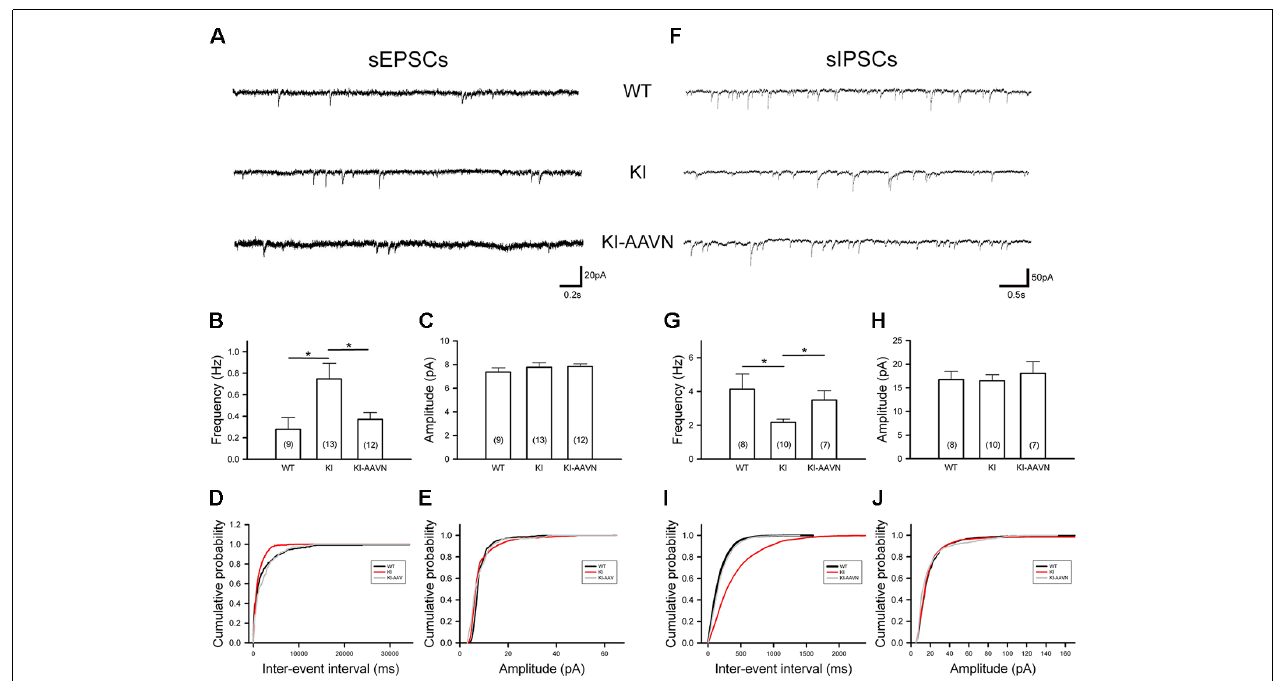
FIGURE 5 | Spontaneous excitatory postsynaptic currents (sEPSCs) and spontaneous inhibitory PSCs (sIPSCs) recorded from SNc DA neurons in WT ( n = 8–9 cells), KI ( n = 10–13 cells), and AAVN-AADC-treated KI (KI-AAVN, n = 7–12 cells) mice. (A) Representative sEPSC traces. (B) Calculated average frequency of sEPSCs. A higher frequency was observed in KI mice, and gene therapy corrected this abnormality. Scale bars: 0.2 s and 20 pA. (C) The calculated average amplitude of sEPSCs was not different between the three groups of mice. (D) A cumulative probability plot of inter-event intervals revealed a smaller interval in KI mice. (E) The cumulative probability plot of amplitudes revealed no difference between the three groups. (F) Representative sIPSC traces. Scale bars: 0.5 s and 50 pA. (G) Calculated average frequency of sIPSCs. The frequency was lower in KI mice than in WT mice, and gene therapy corrected this abnormality. (H) The calculated average amplitudes of sIPSCs were not different between the two groups. (I) The cumulative probability plot of inter-event intervals revealed a larger interval in KI mice. (J) The cumulative probability plot of amplitudes revealed no difference between the two groups. Data are presented as the mean ± SEM, ∗ p < 0.05, n = 4–6 in each